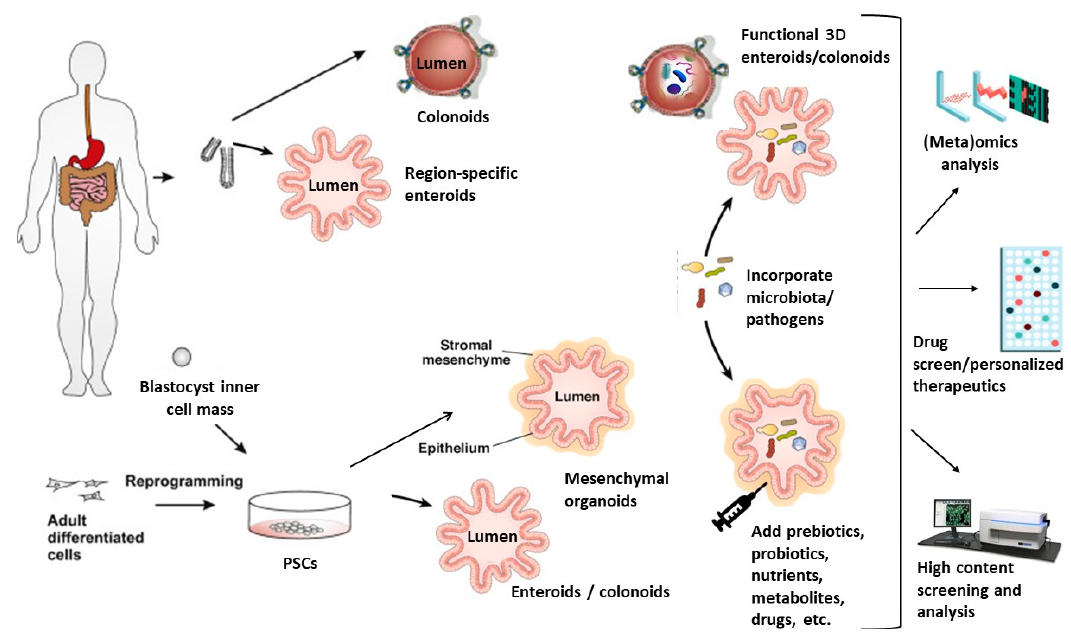
Figure 1. Human intestinal epithelial organoids (hiOs) generation and examples of their applications in the study of the relations between nutrition, infectious diseases, and microbiota. PSCs: Pluripotent stem cells.